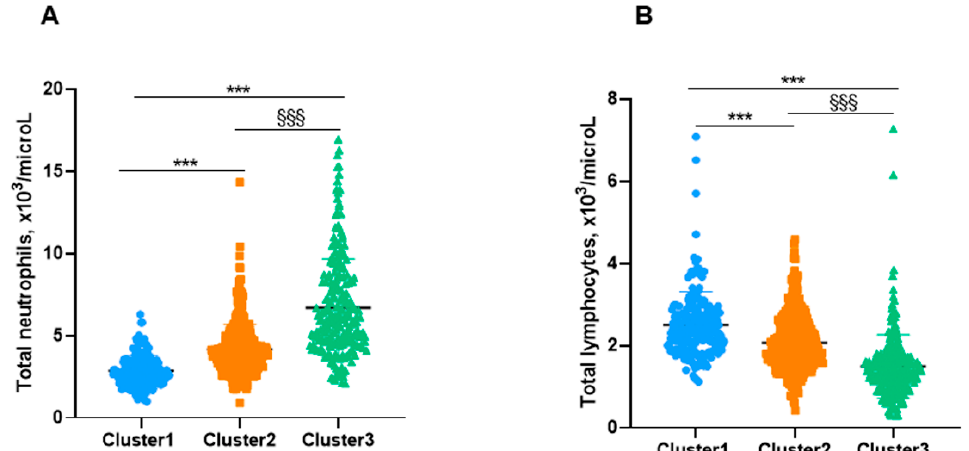
Figure 6. ( A ) Mean values and standard deviation of total number of neutrophils (10 3 /microL) in the three clusters of patients excluding those with COPD. ( B ) Mean values and standard deviation of total number of lymphocytes (10 3 /microL) in the three clusters of patients excluding those with COPD. Statistical significance: ***, p ≤ 0.001: Comparisons were assessed between either group # 3 or group # 2 and group # 1 (less severe §§§, p ≤ 0.001: Comparisons between groups # 3 and # 2.